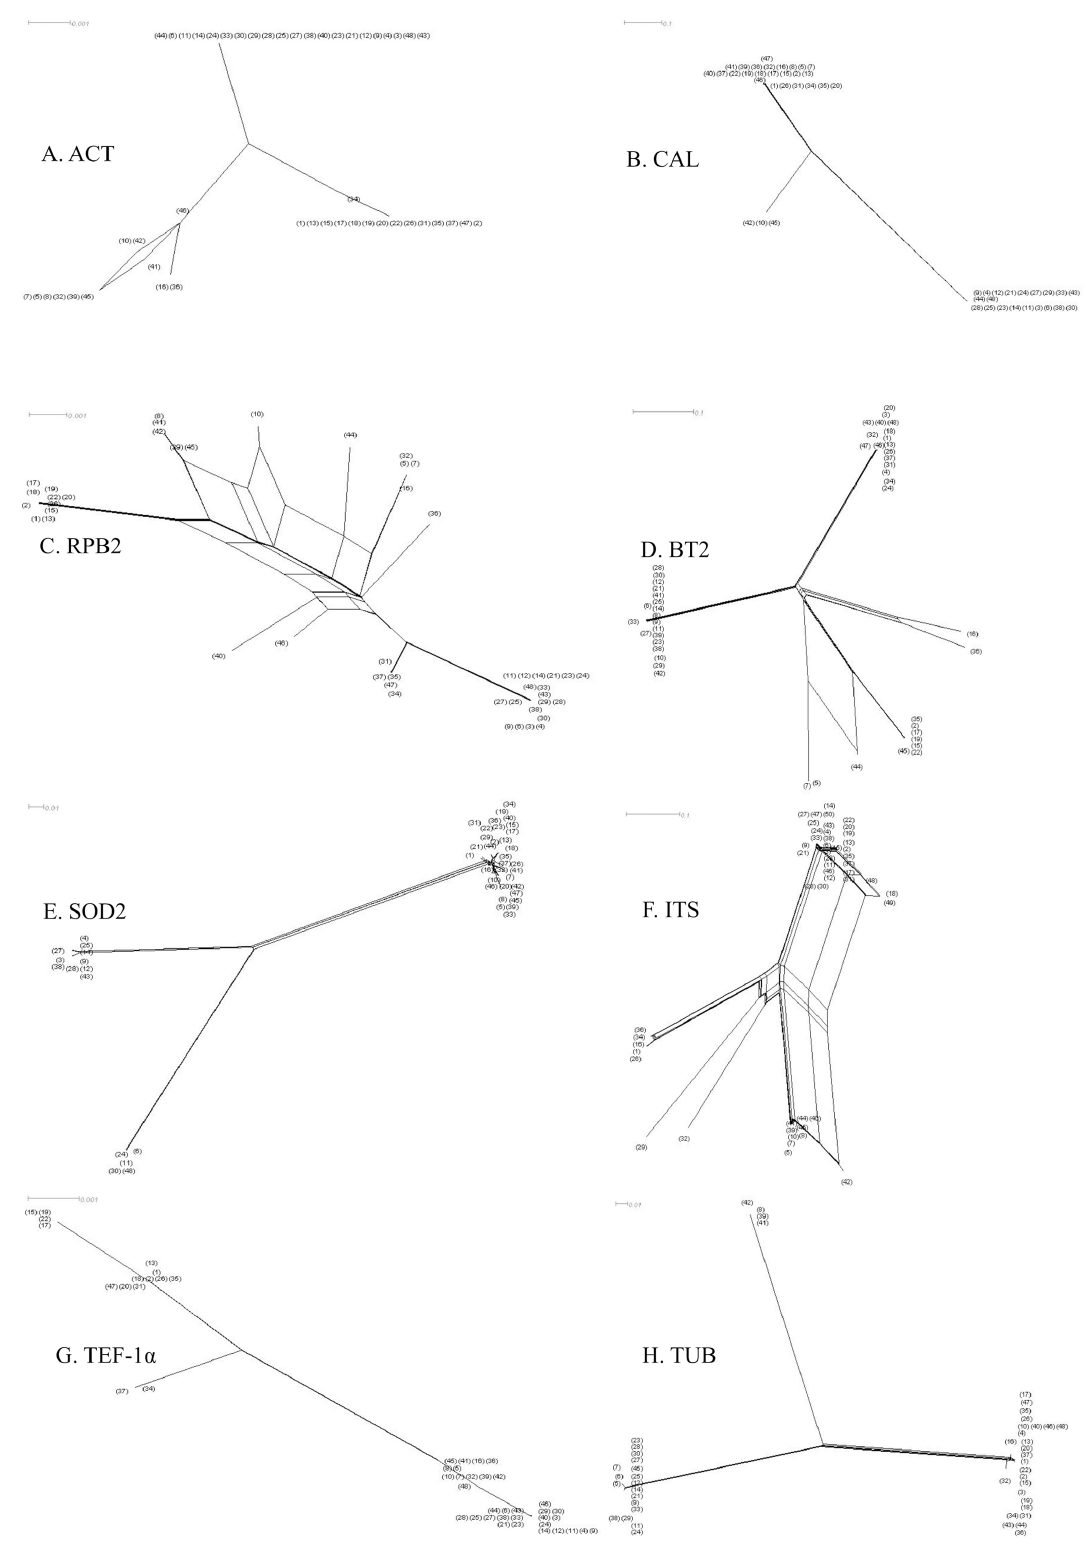
Fig 1. Phylogenetic network (A–H). SplitTree decomposition analysisusing the neighbor-net algorithmof each of the eight genesi.e. A. ACT, B. CAL, C. RPB2, D. BT2, E. SOD2, F. ITS, G. TEF-1 α and H. TUB (in blanketto show the number of the collectionname of each